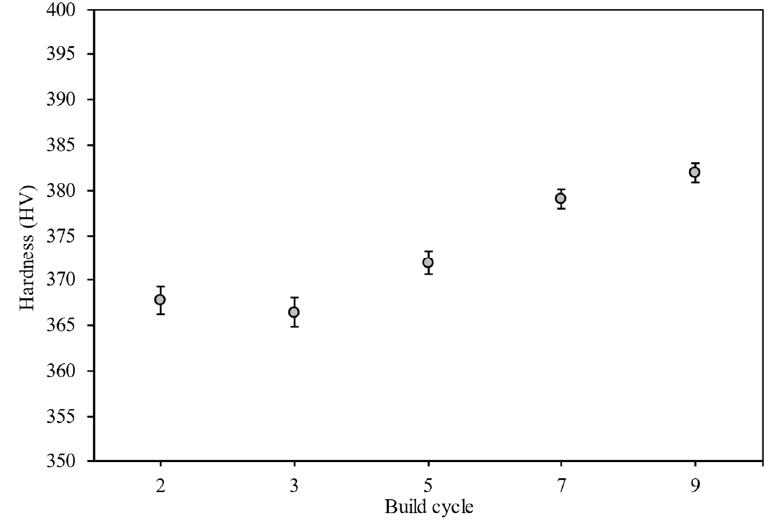
Figure 6. Mean Vickers hardness measured along the vertical centerline of each central cylinder. Error bars show standard errors.